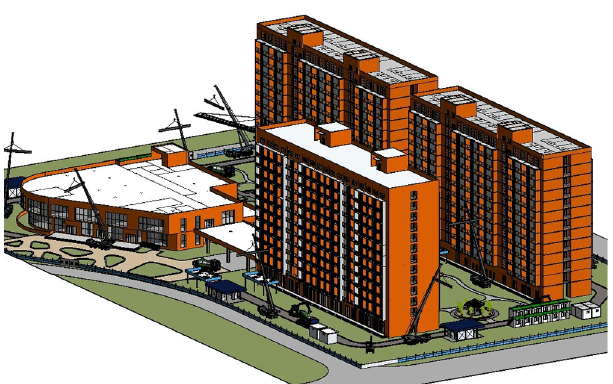
Figure 13. BIM security information model.